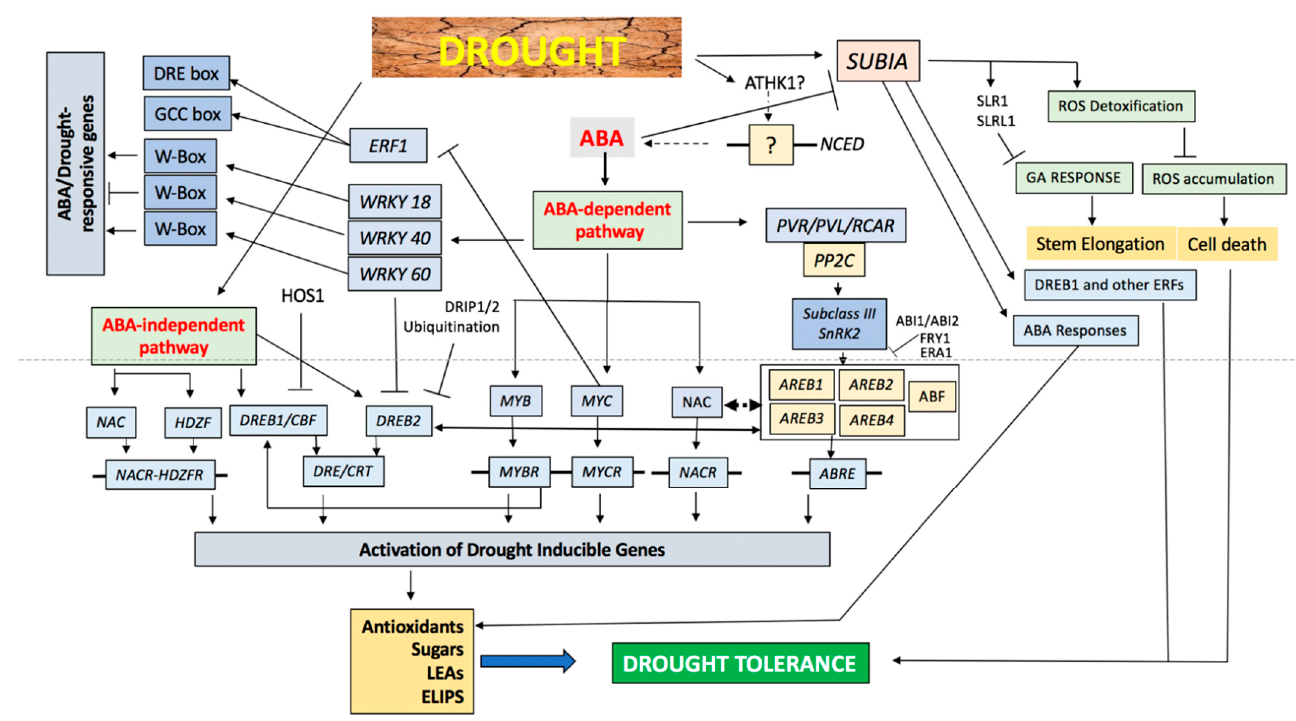
Figure 3. A schematic model of transcriptional regulatory networks and gene expression in the drought stress signals.